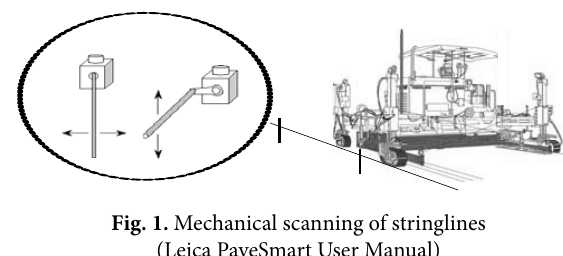
Fig. 1. Mechanical scanning of stringlines (Leica PaveSmart User